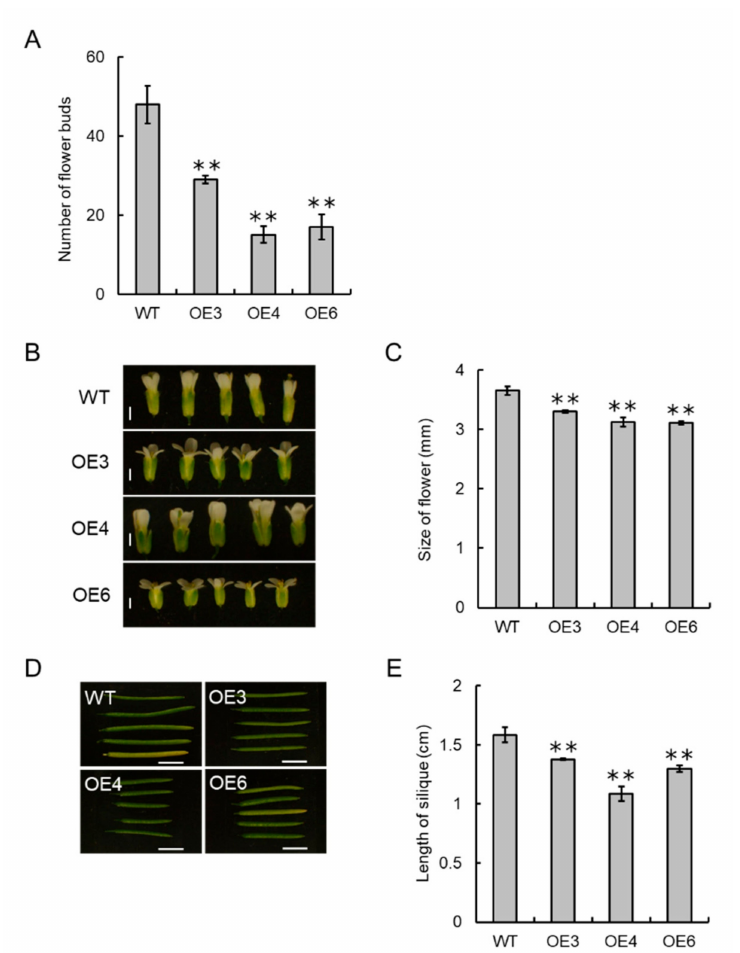
Figure 7. Overexpression of VvCKX5 decreases the number of flower buds per inflorescence in Arabidopsis plants. ( A ) Number of flower buds per inflorescence in transgenic and wild type plants. The number of flower buds per inflorescence in each plant was measured on day 42 (wild type) or 57 (transgenic) after sowing. Bars indicate means ± standard deviations of three independent plants. ** p < 0.01 as compared with wild type (Dunnett’s test). ( B ) Phenotypes of flowers on day 35 (wild type) or 52 (transgenic) after sowing. Scale bar = 1 mm. ( C ) Flower size. Sizes of flowers on